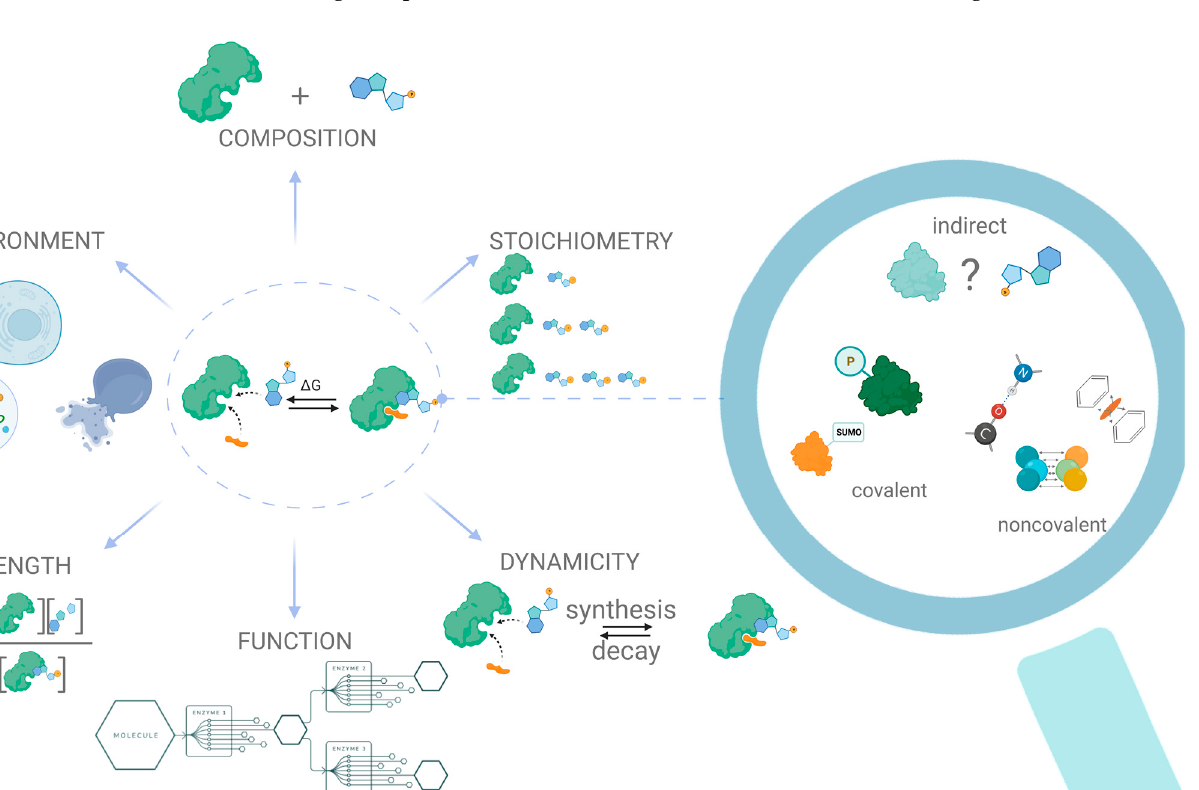
Figure 1. General classification of the type of interaction and challenges in protein–metabolite